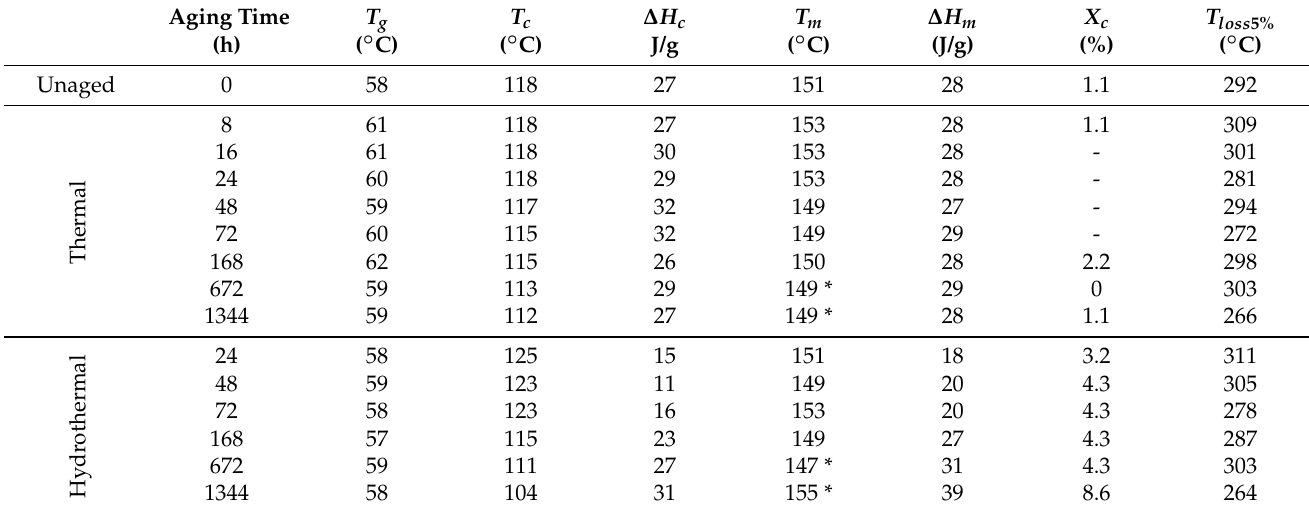
Table 2. Results of the thermal analysis of the specimens after aging. Samples that registered a double peak when melting are marked with an asterisk (*). The second peak (the one at a greater temperature) is also shown, considered as T m